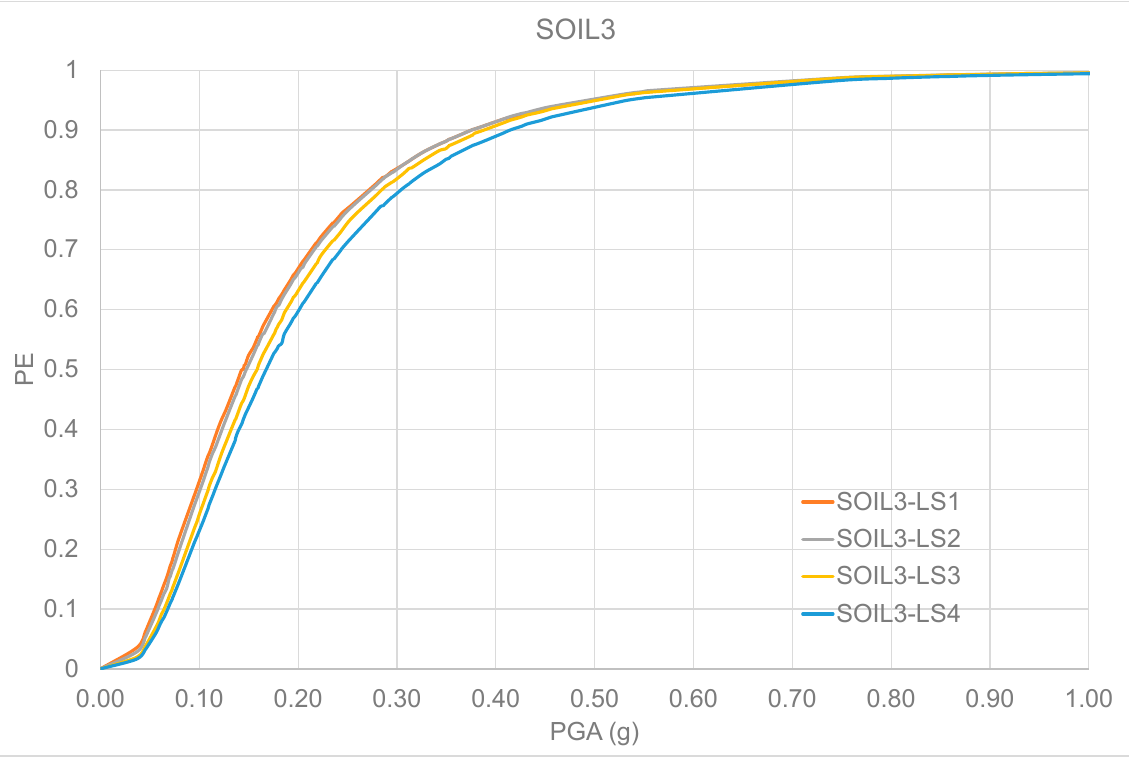
Figure 11. Fragility Curves: SOIL3.